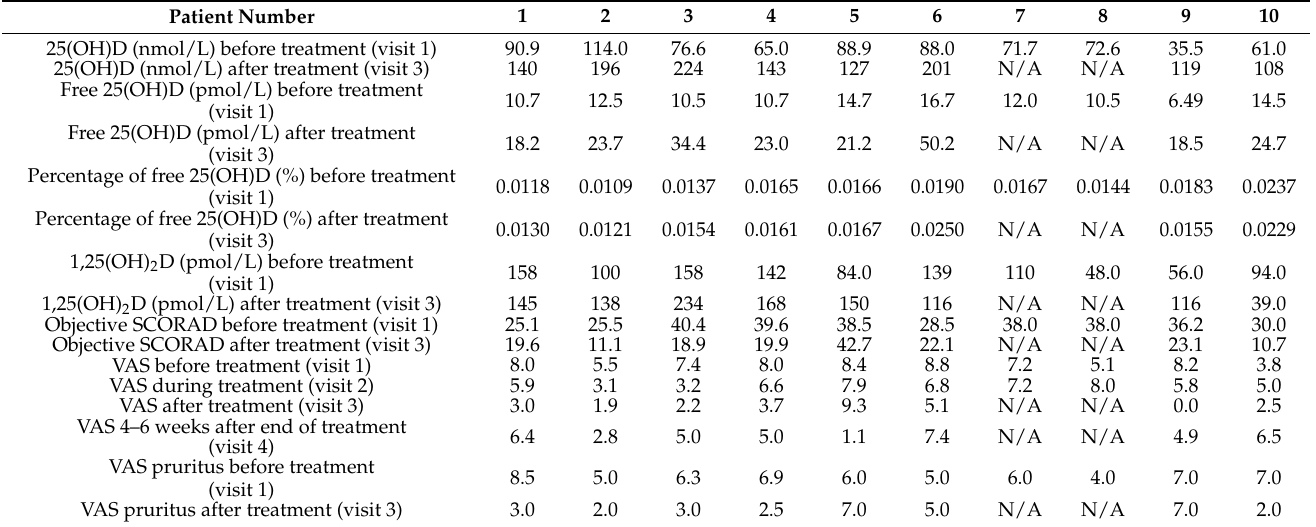
Table 2. Effects of narrow-band UVB phototherapy on vitamin D levels and disease severity measured with objective SCORing Atopic Dermatitis (SCORAD) in atopic dermatitis (AD) patients. Subjective disease burden measured with visual analogue scale (VAS) and VAS pruritus. Timepoints for assessment were: before treatment (visit 1), during treatment (approximately 4 weeks in) (visit 2), after treatment (when treatment was ended at week 10–12) (visit 3), and 4–6 weeks after end of treatment (visit